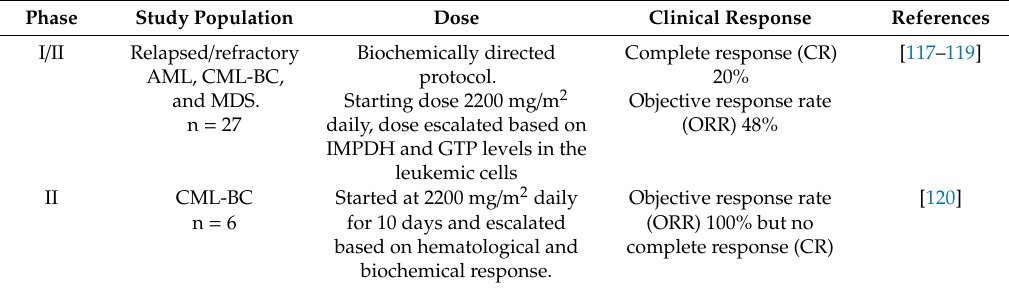
Table 2. Summary of clinical trials of Tiazofurin for hematological malignancy .